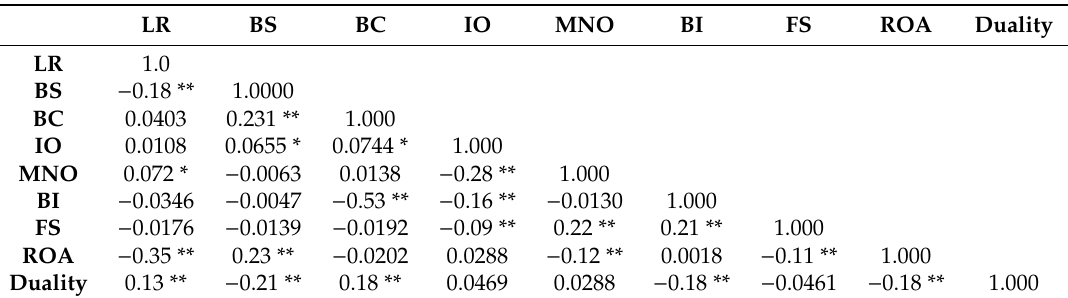
Table 3. Pearson Correlation Matrix of Variables.